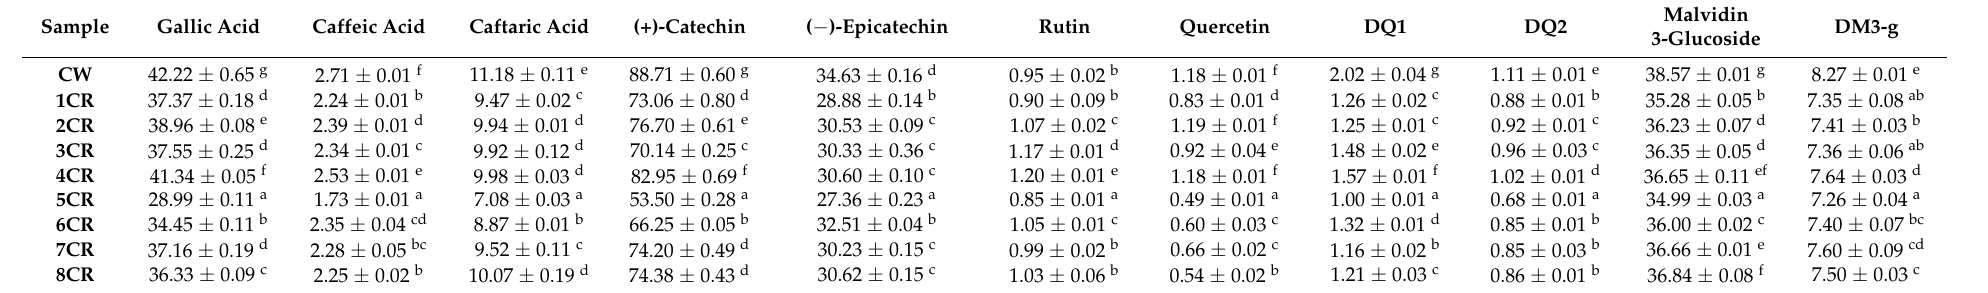
Significant differences ( p < 0.05) between samples are indicated by different superscript letters within the column (ANOVA; Fisher’s LSD test). Abbreviations: CW—initial conventional wine; CR—reverse osmosis retentate of conventional wine; 1—2.5 MPa with cooling; 2—3.5 MPa with cooling; 3—4.5 MPa with cooling; 4—5.5 MPa with cooling; 5—2.5 MPa without